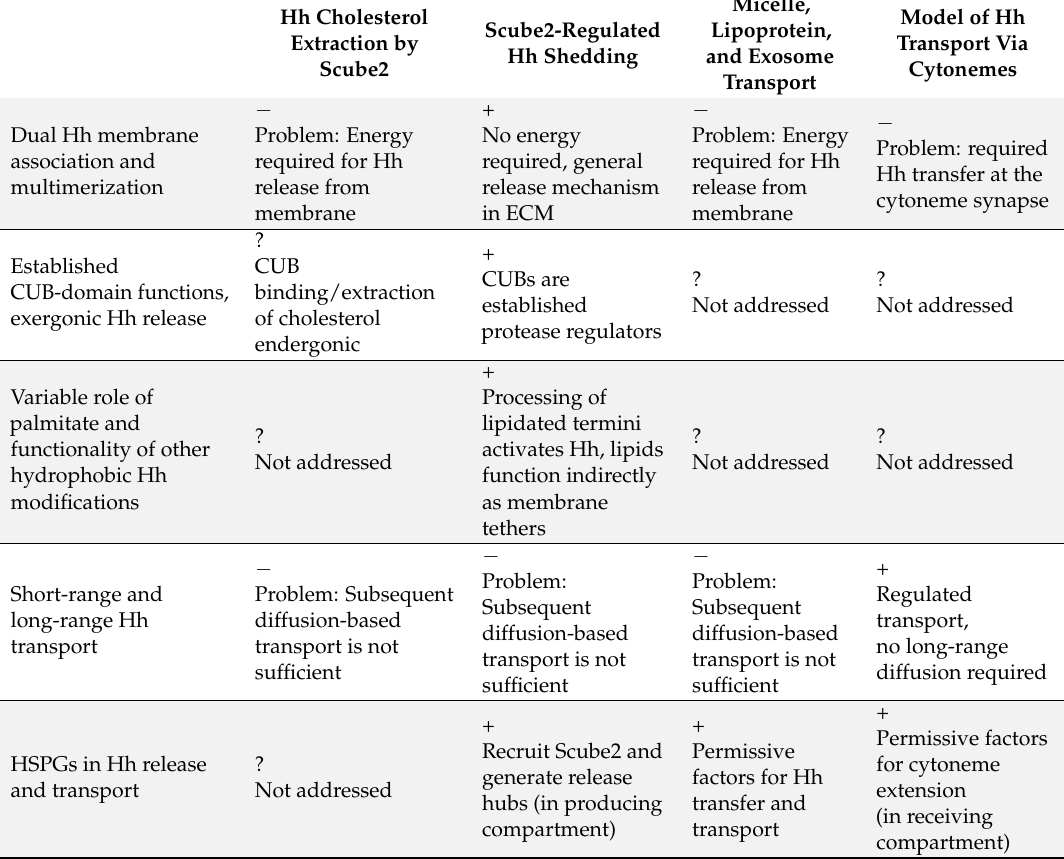
Table 1. Summary of proposed models of Hh release and transport (top) and their compatibility with established biochemical properties of Hh proteins and CUB-domain functions (left). − : incompatible. ?: unknown; +: compatible. Note that combined cytoneme Hh transport to target tissues and proteolytic Hh release at these sites is consistent with, and explains, dual Hh lipidation and membrane association, established Scube2 CUB-domain functions as protease enhancers, the essential yet variable role of N-palmitate for Hh biofunction, differential Hh short- and long-range transport to Ptc-receptors on target cells, and the essential roles of HSPGs in Hh-producing (Shedding) and -receiving (Cytonemes) cells. See text for